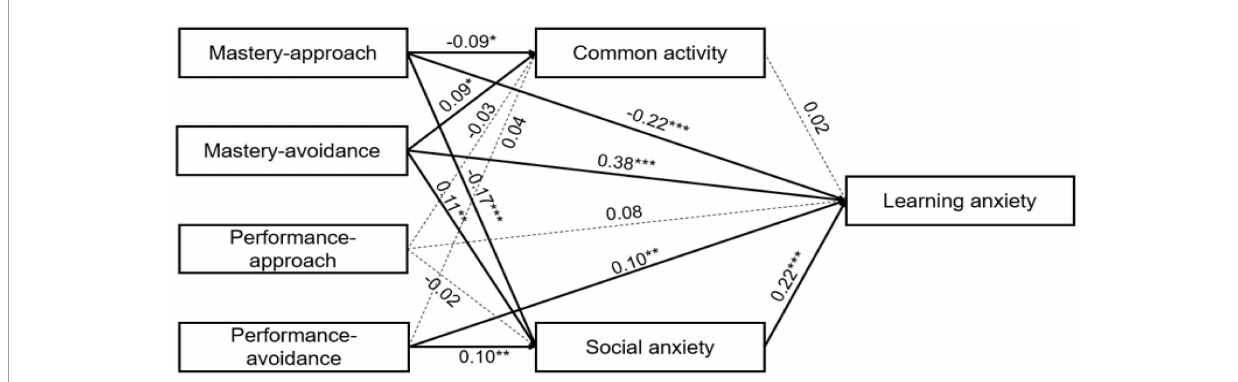
FIGURE1 Structural equation model predicting adolescents’ learning anxiety. This structural equation model predicts adolescents’ learning anxiety from achievement orientation, with mediating effect of three dimensions of the peer interaction. To make the model clear, the control variables (gender and grade), another insignificant variable (intimate relation), and the path coefficients are not shown in figure. Statistics are standardized regression coefficients. Dotted lines represent non-significant relations; bold lines represent significant indirect paths. * p < 0.05, ** p < 0.01, *** p < 0.001.